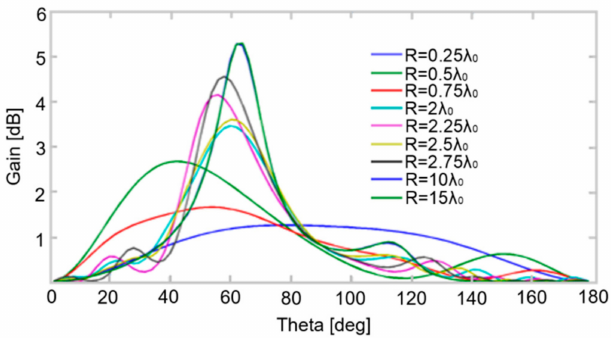
Figure 3. Radiation patterns of center located monopole on different sizes of the ground plane. Placing the antenna on the side of the ground plane may be one effective way to roof. Hence, monopole antennas in several off-centered mounting configurations are also height and the radius of the ground plane are set to 0.22 λ 0 and 2 λ 0 , respectively, the current are shown in Figure 4.